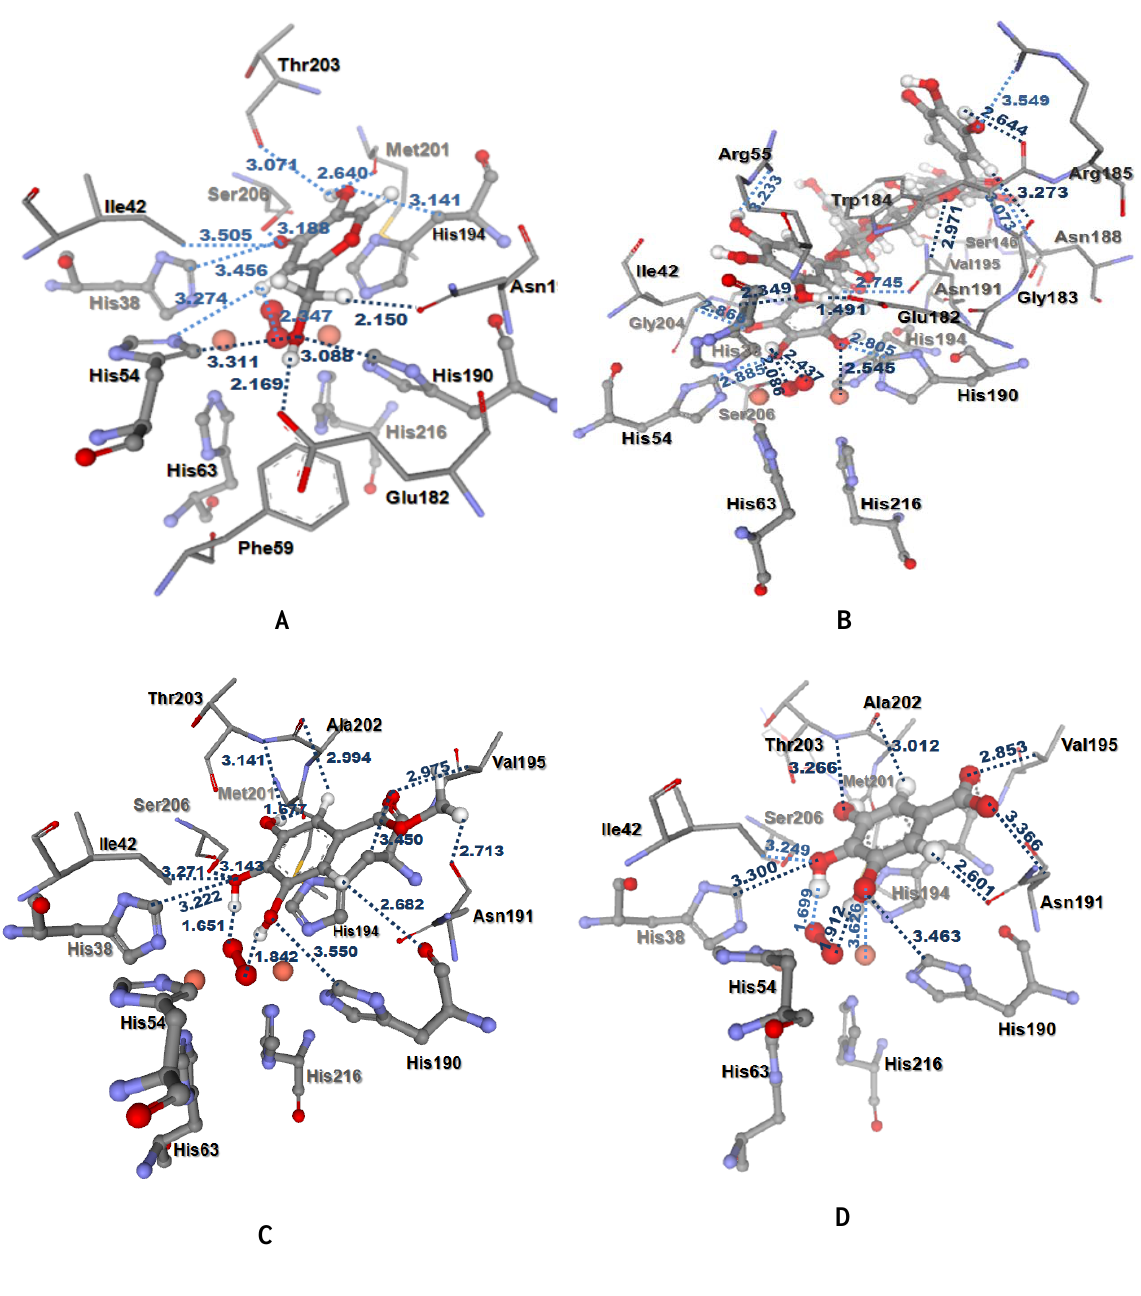
Figure 3 . Distances (in Å) between residues in the tyrosinase binding pocket and